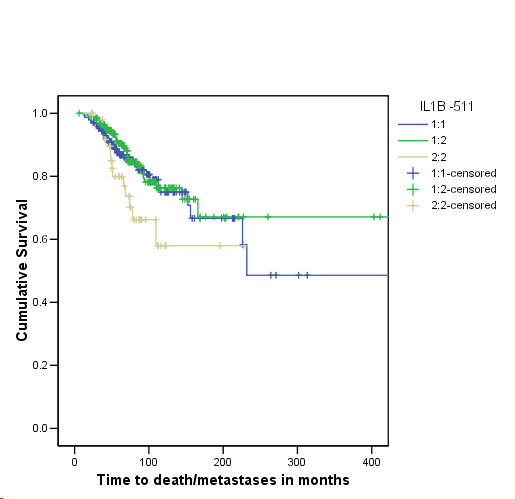
shows the time to death or metastases in invasive breast cancer for the genotypes of the IL1B -511 polymorphism. Log Rank test statistic = 5.07; df = 2; p = 0.08 (n = 484).